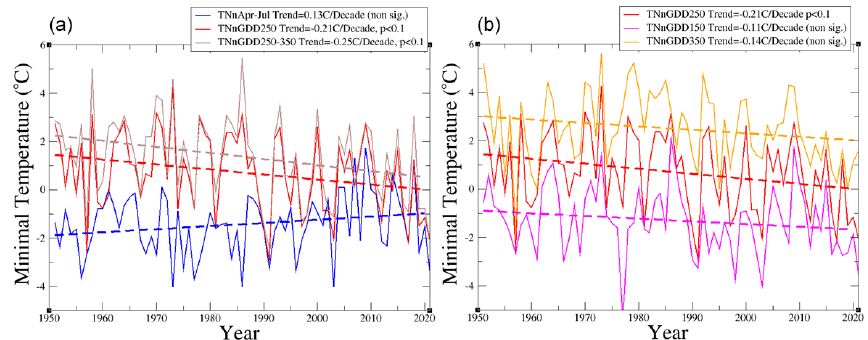
Figure 4. (a) Time series of the yearly indices and their respective linear trends calculated over the 1951–2020 period. (b) The same as panel (a) but for TNnGDD250, TNnGDD150 and